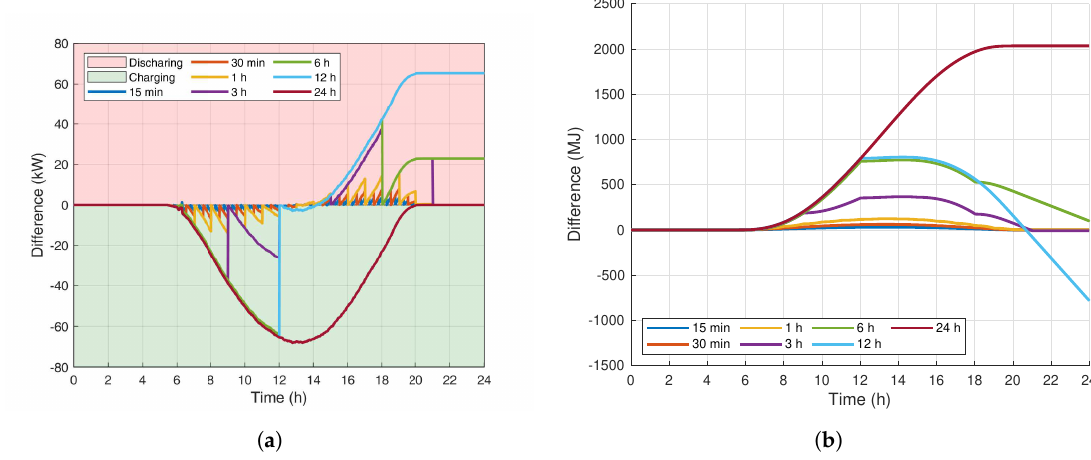
Figure 8. The resulting PV power and energy forecast differences which rise from the use of temperature and solar irradiance forecast when compared to the known truth atmospheric time series of the renewable asset assuming MPPT for the clear sky conditions. ( a ) The clear sky PV power forecast differences. ( b ) The clear sky PV energy forecast